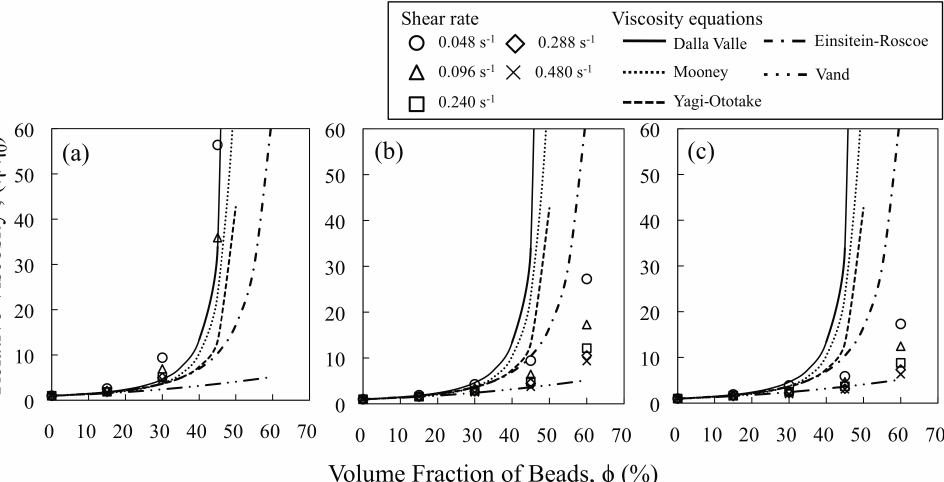
Figure 4. Comparisons of the viscosity equations with relative viscosity of suspension measured in the present study. (Mean diameter of beads: (a) 9.35 µm, (b) 162.5 µm, (c) 602.5